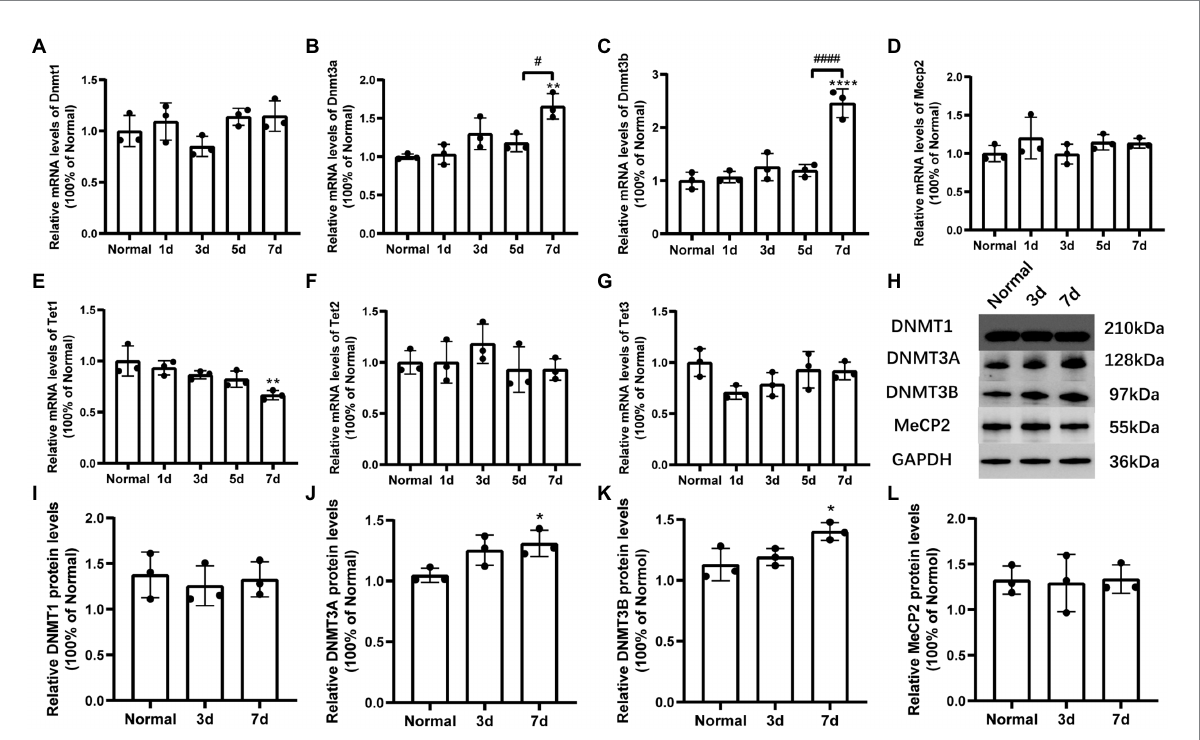
FIGURE 5 Changes of mRNA and protein levels of DNA methylation-related factors induced by MMS treatment. (A–G) The mRNA levels of Dnmt1/3a/3b , Mecp2, and Tet1/2/3 at 7 days after MMS treatment compared to Normal groups. (H) Representative immunoblots of DNMT1/3A/3B, MeCP2, GAPDH were used as an internal control. (I–L) Quantitative analysis of protein levels related to GAPDH. Data were expressed as mean ± SD, n = 3/group. * p < 0.05, ** p < 0.01, **** p < 0.0001 for differences compared to Normal groups, # p < 0.05, #### p < 0.0001 for differences compared to previous time point